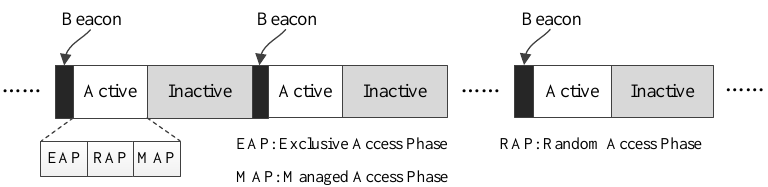
Figure 1. The scenario that 802.15.6 is applied to a low data-rate